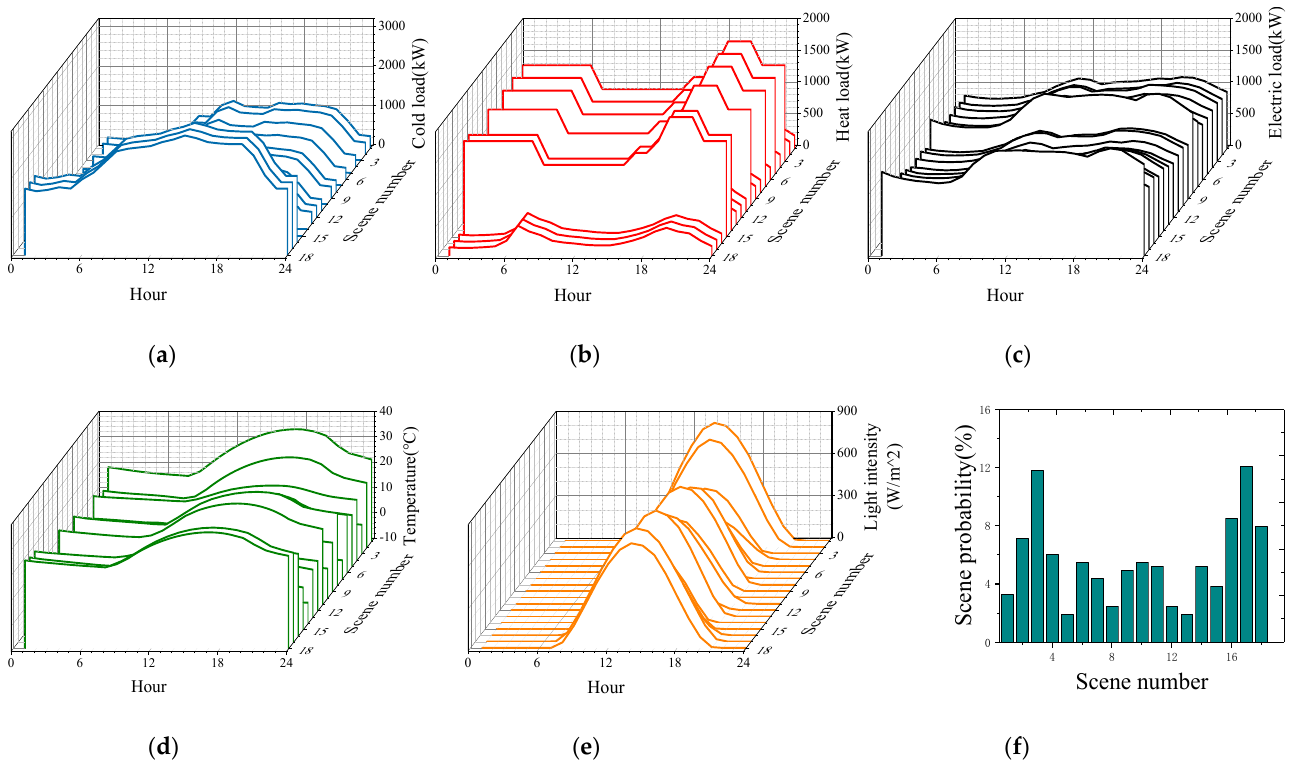
Figure 10. ( a ) Heat load clustering result based on improved FCM algorithm; ( b ) Heat load clustering result based on improved FCM algorithm; ( c ) Electric load clustering result based on improved FCM algorithm; ( d ) Temperature data clustering result based on improved FCM algorithm; ( e ) Light intensity data clustering result based on improved FCM algorithm; ( f ). Probability of each clustering scene.